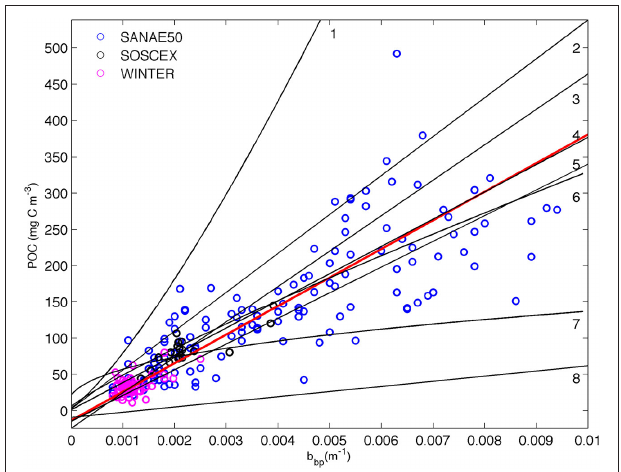
FIGURE 2 | Relationship between in situ POC and particulate backscattering ( b bp 470 nm) from cruise data (Table 1, SANAE53 was excluded as corresponding CTD backscattering data were not available) with the linear least squared regression ( r 2 = 0.93) plotted in solid red. Overlain with fits (summarized in ( Cetini ´ c et al., 2012)) from (1) Stramski et al. (1999) from Ross Sea; (2) Stramski et al. (2008) from Atlantic/Pacific (excluding upwelling data); (3) Graff et al. (2015) from the North and South Atlantic and Equatorial Pacific; (4) Loisel et al. (2001) from Mediterranean; (5) Cetini ´ c et al. (2012) from North Atlantic; (6) Stramski et al. (1999) from the Polar Frontal Zone (PFZ); (7) Balch et al. (2010) from north and